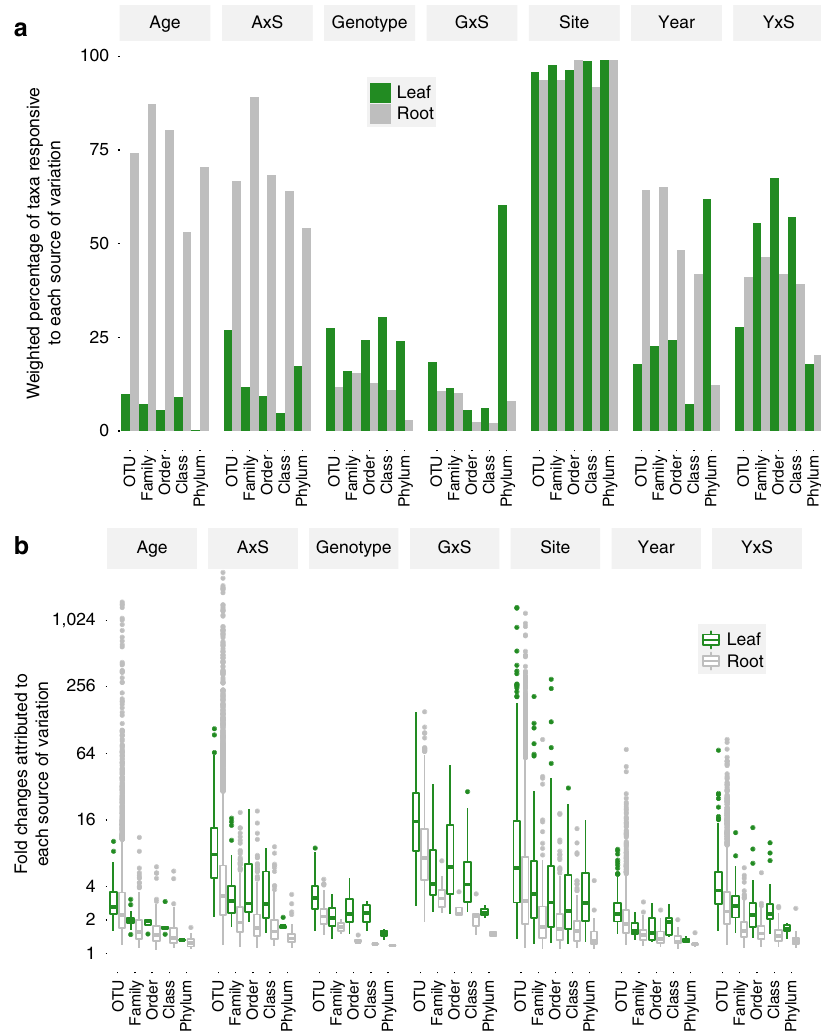
Figure 3 | Individual bacterial taxa at multiple taxonomic levels are sensitive to several interacting factors. Abundances of bacterial OTUs, families, orders, classes and phyla were individually modelled using NBMs. Sample sizes are N ¼ 306 for leaves and N ¼ 310 for roots. Significance was assessed using a Likelihood ratio test at P o 0.05 after correction for multiple comparisons using Benjamini–Hochberg false discovery rate. ‘Geno’ ¼ genotype; ‘GxS’ ¼ genotype-by-site interactions; ‘AxS’ ¼ age-by-site interactions; ‘YxS’ ¼ year-by-site interactions. ( a ) Bar plots show the total relative abundance of bacterial taxa predicted by each source of variation (top horizontal axis) at multiple taxonomic levels (bottom horizontal axis), in variance-stabilized NBMs. ( b ) Effect sizes (fold changes between experimental groups for each term on the top horizontal axis) are plotted for all statistically significant pairwise contrasts predicted by variance-stabilized NBMs (Wald test, P o 0.05). The bottom and top edges of the boxes mark the 25th and 75th percentiles (that is, first and third quartiles). The horizontal line within the box denotes the median. Whiskers mark the range of the data excluding outliers (green or grey dots) that fell more than 1.5 times the interquartile range below the first quartile or above the third quartile. To improve readability of the plot, the vertical axis was truncated at 2 11 , concealing seven extreme outliers: all were root-associated OTUs with extreme changes in abundance due to age-by-site